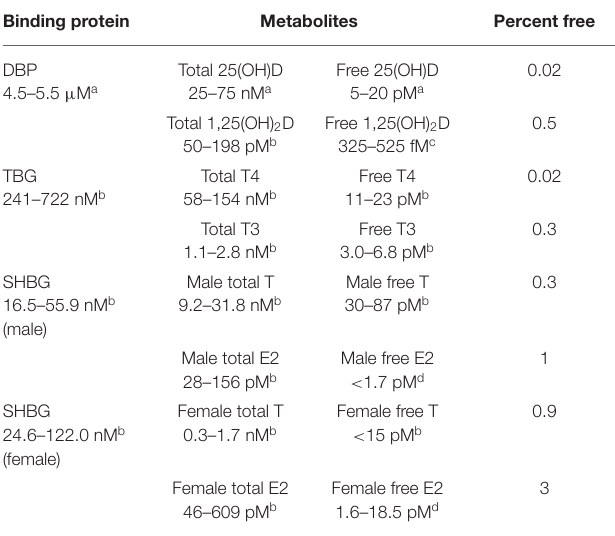
TABLE 3 | Hormone binding proteins found in human serum. Binding protein